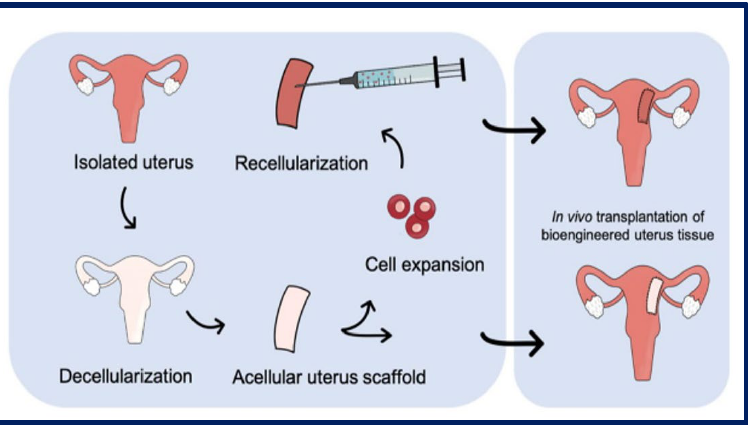
Figure 14. Uterus decellularization process and subsequent cellularization. Bibliography consulted [118] is licensed under CC BY 2.0. To view a copy of this license, visit http://creativecommons.org/li- censes/by/4.0/, (accessed on 15 December 2022).